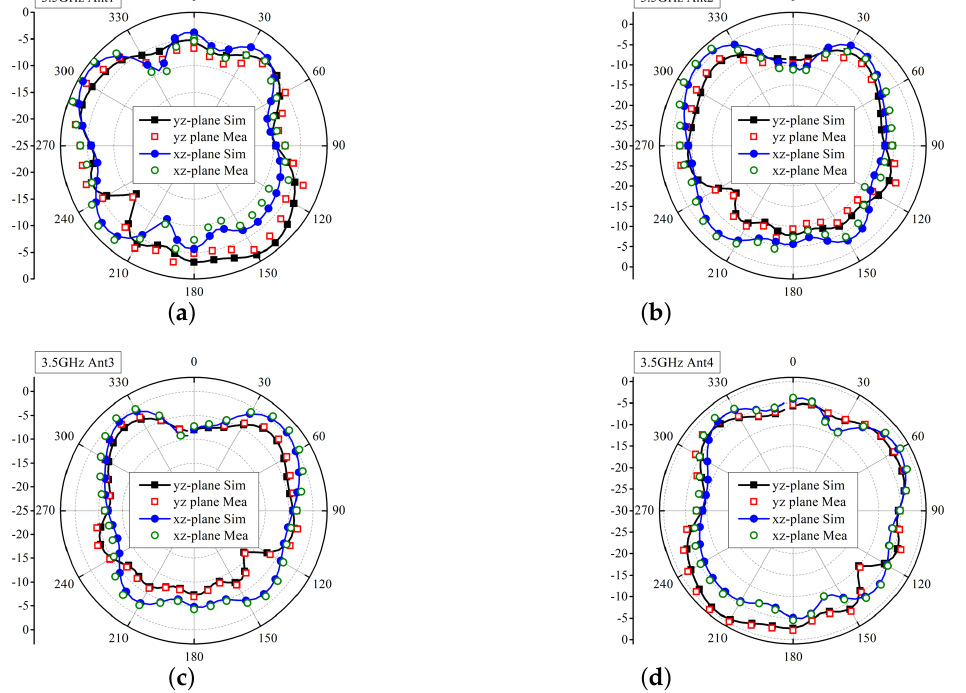
Figure 9. Radiation characteristics of the proposed antenna at 3.5 GHz for ( a ) Ant 1, ( b ) Ant 2, ( c ) Ant 3, and ( d ) Ant 4.